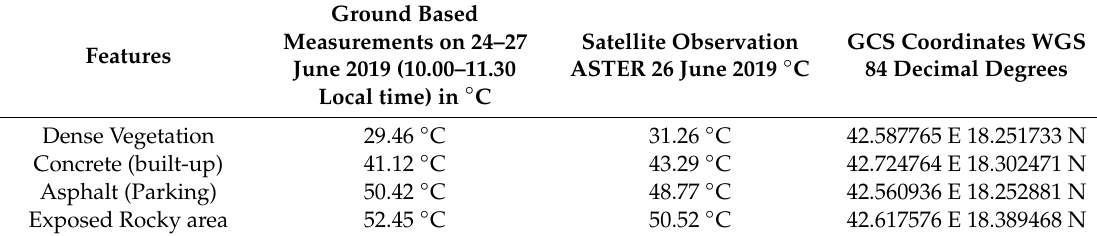
Figure 3. Graphical distribution of mean Land surface temperature (LST) and normalized difference vegetation index (NDVI) in different land use/land cover (LULC) class. Table 1. Comparison of field observation temperature with satellite LST observation.